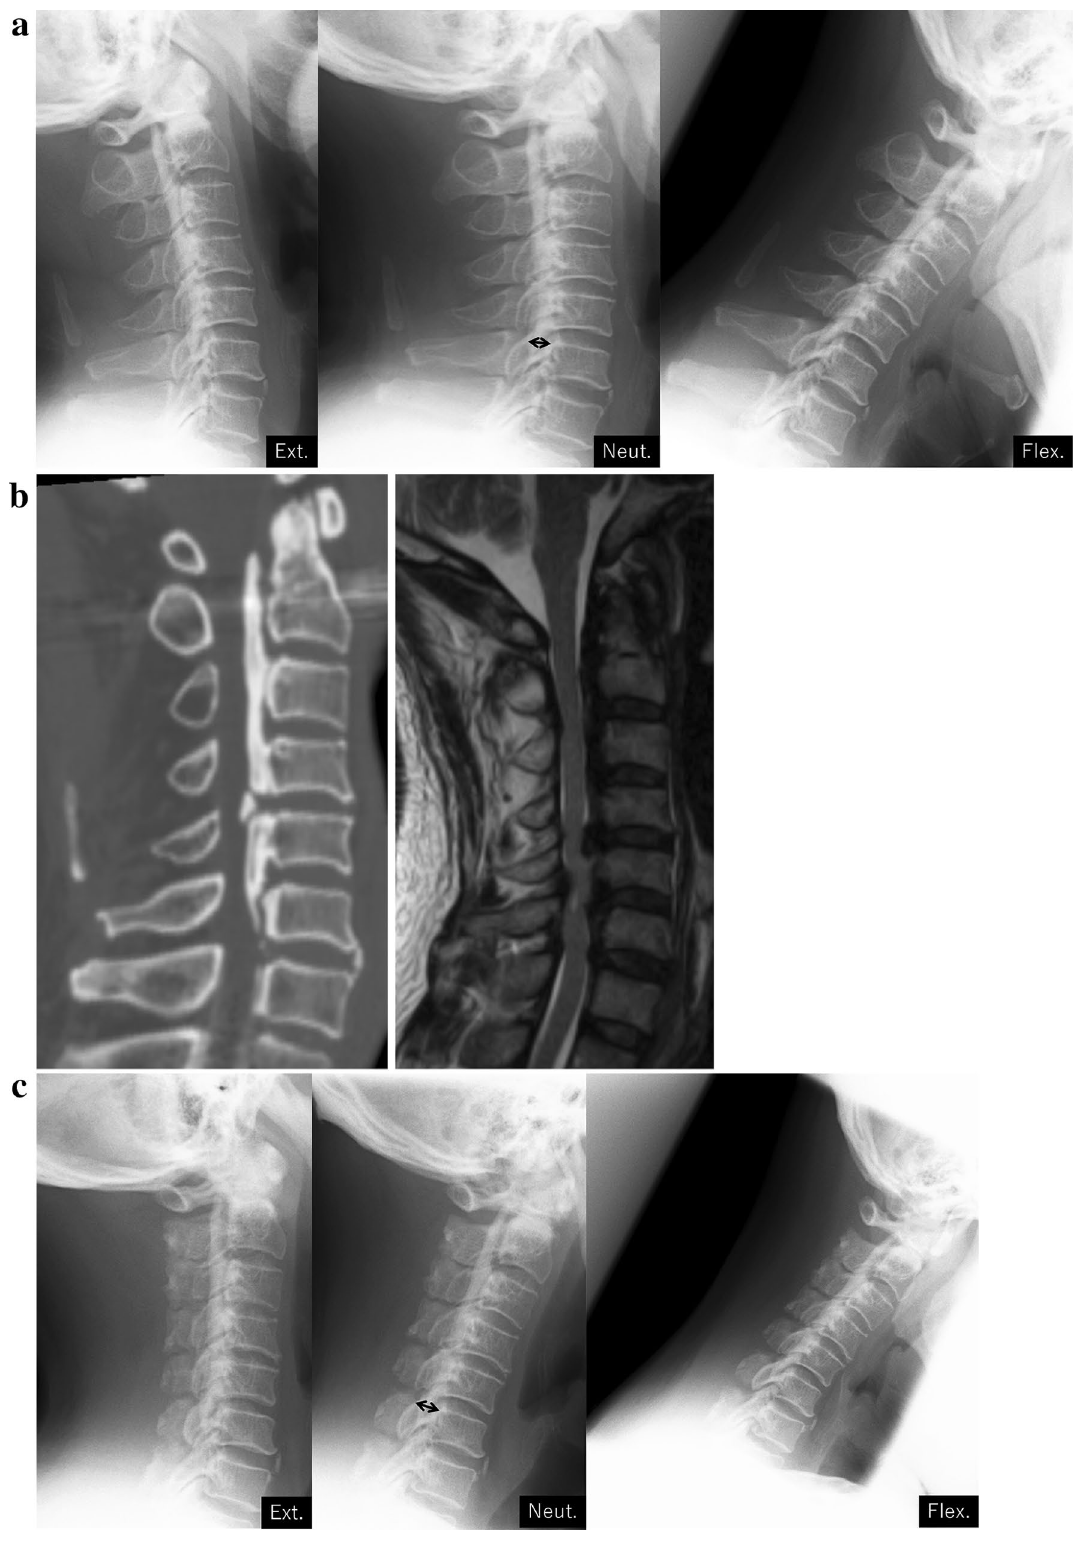
Figure 2. A representative case of cervical laminoplasty. ( a ): preoperative functional X-rays. The thickness of OPLL was 7.1 mm (double-arrow). The neutral position and range of motion at C2-C7 were 9° and 40°. ( b ) Preoperative CT and MRI sagittal images. ( c ) Two years postoperative functional X-rays. The thickness of OPLL was 9.4 mm (double-arrow). The neutral position and range of motion at C2–C7 were 3° and